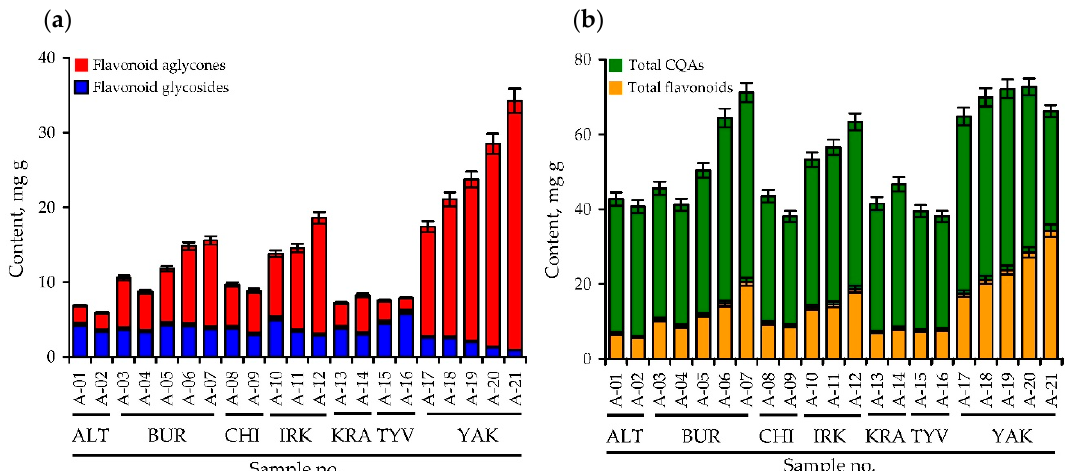
Figure 3. Histograms of the accumulative content of ( a ) flavonoid aglycones and flavonoid glycosides and ( b ) total flavonoids and caffeoylquinic acids (CQAs) in the herb of 21 samples of A. frigida (A-01–A-21). Siberian regions: ALT—Altai Krai, BUR—Buryatia Republic, CHI—Chita Oblast, IRK—Irkutsk